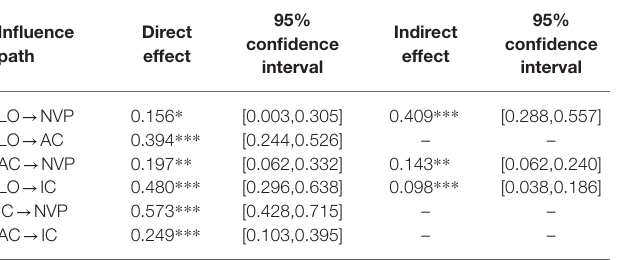
TABLE 4 | Results of the hypothesis